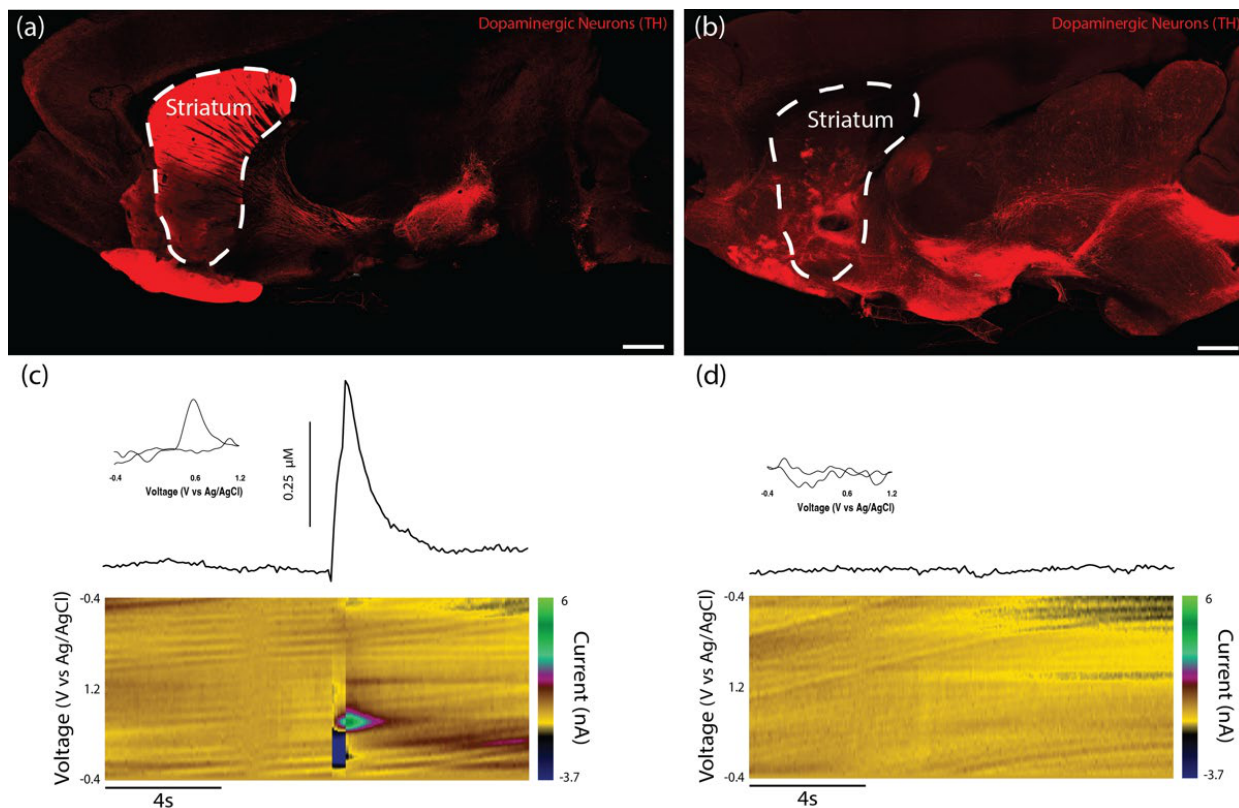
Figure 7. Validation of PD model in athymic rats featuring a 6-OHDA lesion of the SNpc. Athymic rats lesioned by the dopaminergic neurotoxin 6-OHDA injected into the SNpc were used as surgical subjects for the in vivo studies. ( a ) Representative confocal reconstruction of the non-lesioned side of the rat brain labeled via immunocytochemistry to denote dopaminergic neurons/axons (TH, red). As expected, the non-lesioned side demonstrated significant TH labeling within the striatum. ( b ) Representative confocal reconstruction of the lesioned side of the rat brain labeled via immunohistochemistry to denote dopaminergic neurons/axons (TH, red). The lesioned side of the brain demonstrated minimal TH labeling in the striatal region—especially in dorsal striatum—validating the efficacy of the 6-OHDA lesion in destroying dopaminergic neurons in the SNpc and their axons within the nigrostriatal pathway. ( c , d ) Evoked dopamine release was investigated in slices from both the non-lesioned and lesioned sides of the brain using FSCV. ( c ) Representative color plot (bottom), cyclic voltammogram (inset), and time vs. concentration plot (top) of the evoked dopamine release recorded in the non-lesioned side of the brain (n = 3) as potential of the carbon fiber electrode was linearly scanned from −0.4 to 1.2 V and back to −0.4 V vs. Ag/AgCl every 100 ms. The cyclic voltammogram exhibited an oxidation peak between 0.55 and 0.65 V and a reduction trough between −0.2 and −0 .3 V, which are characteristic of dopamine. The maximum concentrations of dopamine released by the non-lesioned side were over 300 nM. ( d ) Representative color plot (bottom), cyclic voltammogram (inset), and time vs. concentration plot (top) of the evoked dopamine release recorded in the lesioned side of the brain (n = 3). The cyclic voltammogram did not exhibit peaks or troughs representative of dopamine, and no discernable concentration of dopamine was recorded. These findings validated the functional consequences of the 6-OHDA lesion in destroying dopaminergic neurons/axons of the nigrostriatal pathway. Scale bar ( a , b ) = 1 mm. 2.7. Structural Analyses Following TE-NSP Implantation into 6-OHDA Lesioned Athymic Rats We